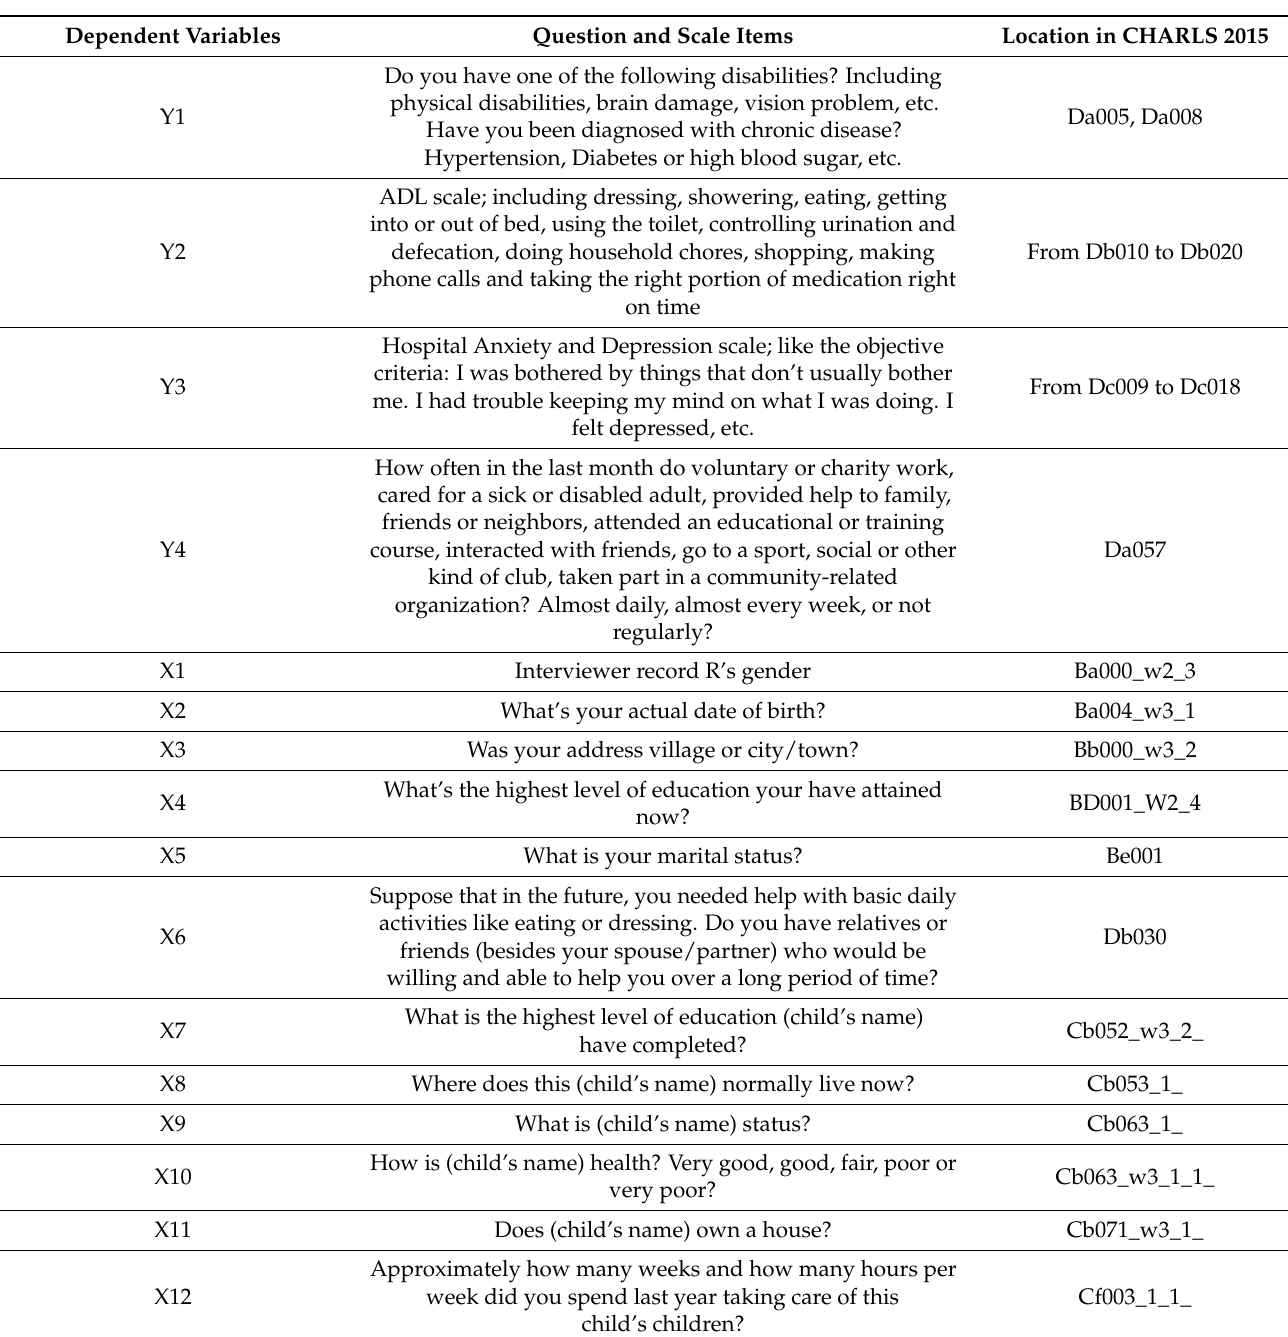
Table A1. Specific items of the scale related to dependent